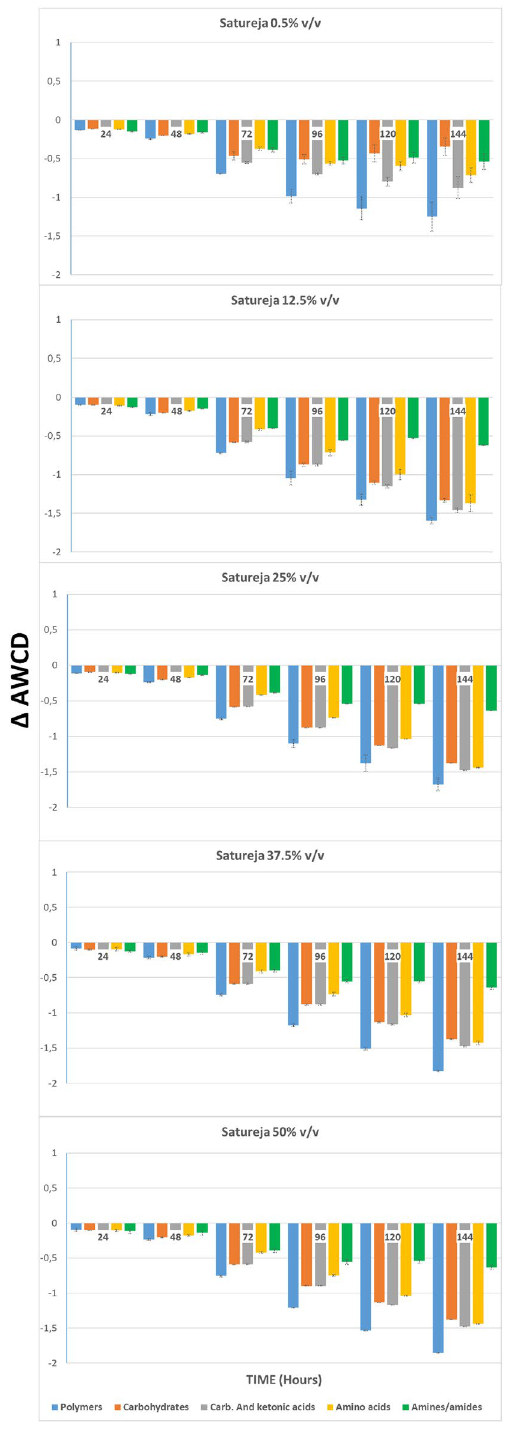
Figure 5. Bars represent the variation of AWCD for each group of metabolites, of soil bacteria communities treated with Satureja montana hydrolate during 144 h. Values were obtained by subtracting those from the negative